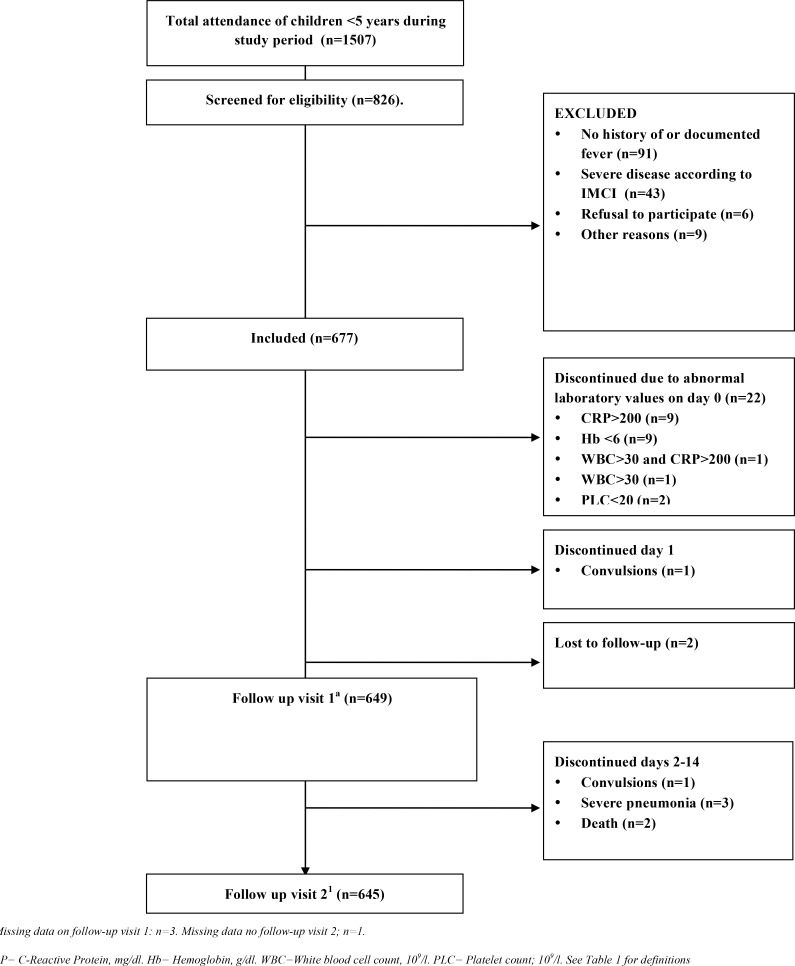
Flow of patients through the study.